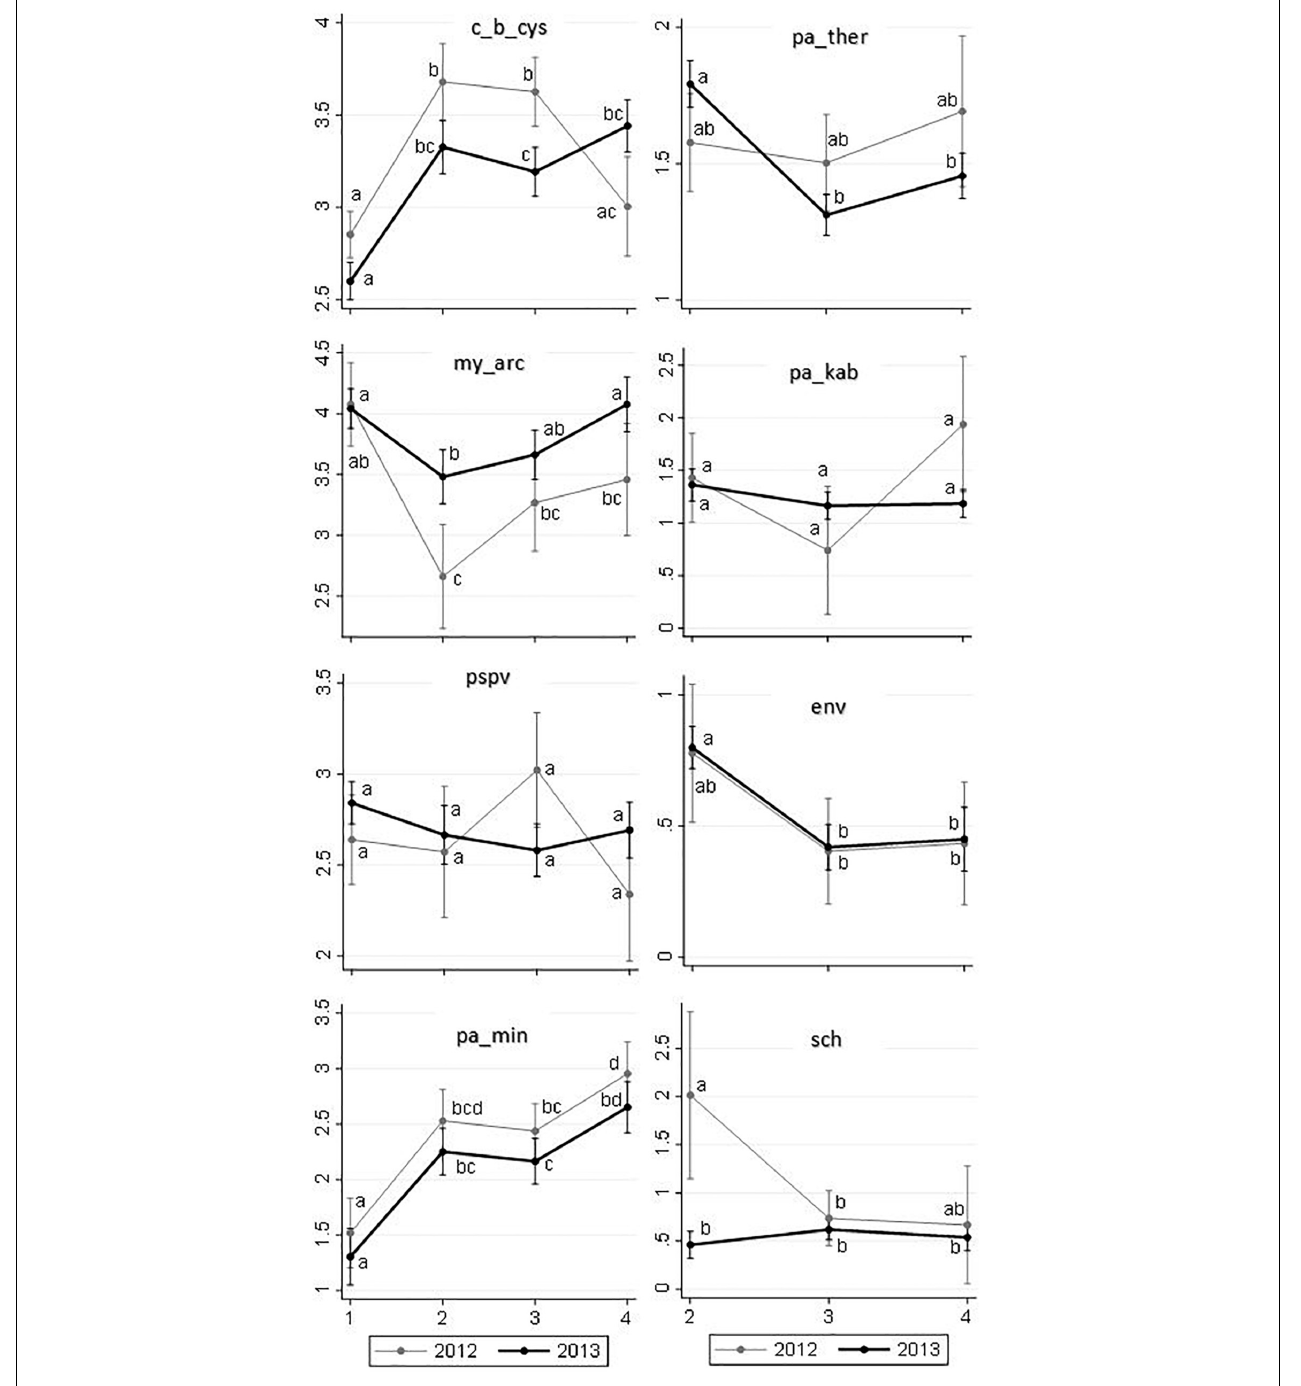
FIGURE 7 | Predicted means of loads for the common infectious agents ( Y -axes) detected in 2,006 out-migrating Fraser River Sockeye salmon, by study region ( X -axes) and year, based on linear regression models. Sampling regions: (1) Freshwater, (2) Strait of Georgia, (3) Discovery Islands, and (4) Johnston Strait and north. Small letters used on the plots represent statistically significant Bonferroni groups, where differences were observed when the points (i.e., unique combinations of region and year) do not have any letters in common ( P < 0.05). If the points shared at least one letter with each other, they were not statistically different ( P > 0.05). Saltwater agents are presented in the right column, which included regions 2–4. A square root transformation was conducted on the loads of P. theridion , P. minibicornis , P. kabatai , ENV, and gill chlamydia in order to meet the normality and homoscedasticity assumptions in their respective linear regression models. The average loads for these agents have been back-transformed to the original scale. Presented 95% confidence interval for each point was calculated using delta method in Stata v15.1.